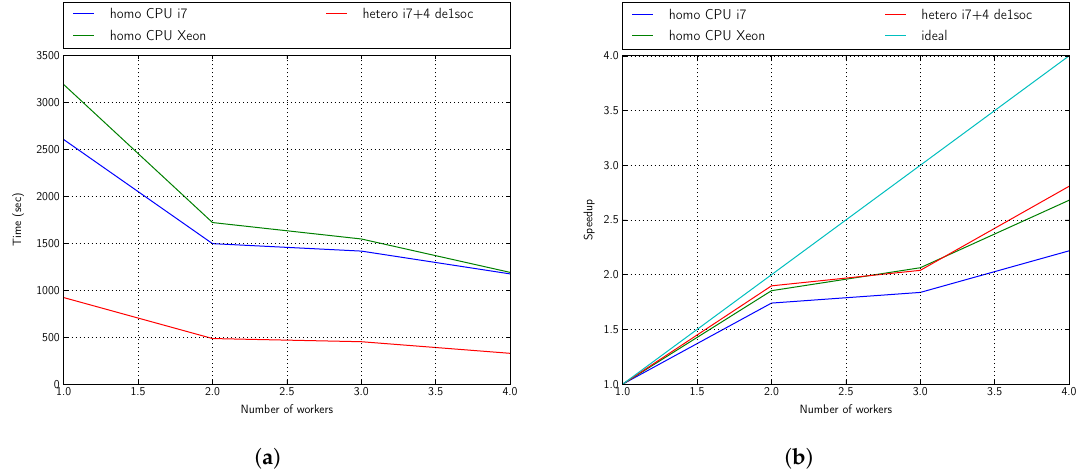
Figure 9. Performance: 5 generations, 4 individuals. ( a ) Time; ( b ) Speedup.